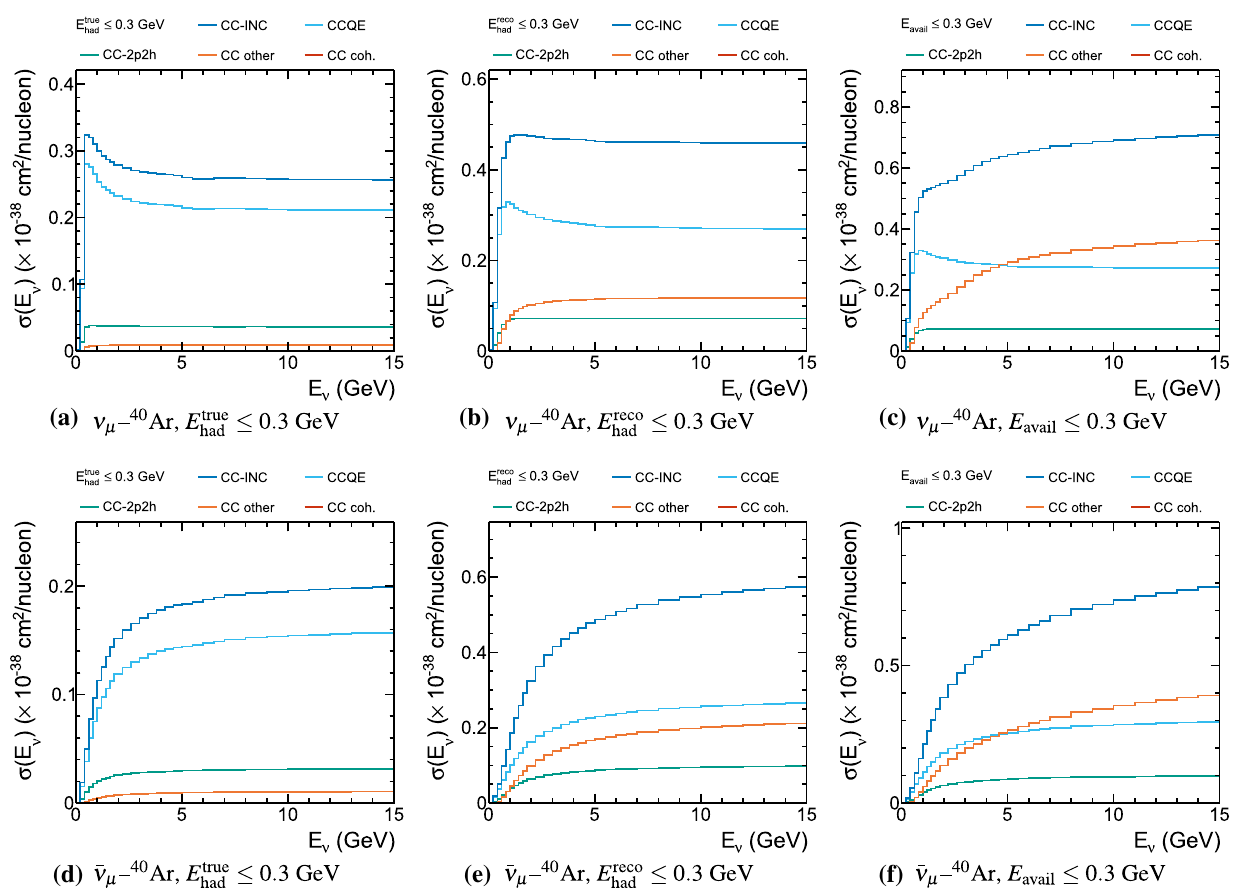
Fig. 8 Contributions to the GENIEv3 10a charged-current ν μ – 40 Ar and ¯ ν μ – 40 Ar cross sections with cuts on the three q 0 proxy variables, E true , E reco , E avail ≤ 0.3 GeV as a function of E true ν , and generated with had had